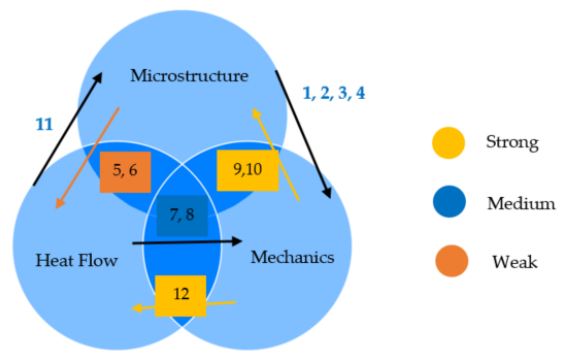
Figure 1. Relations in welding simulations, data from [3].